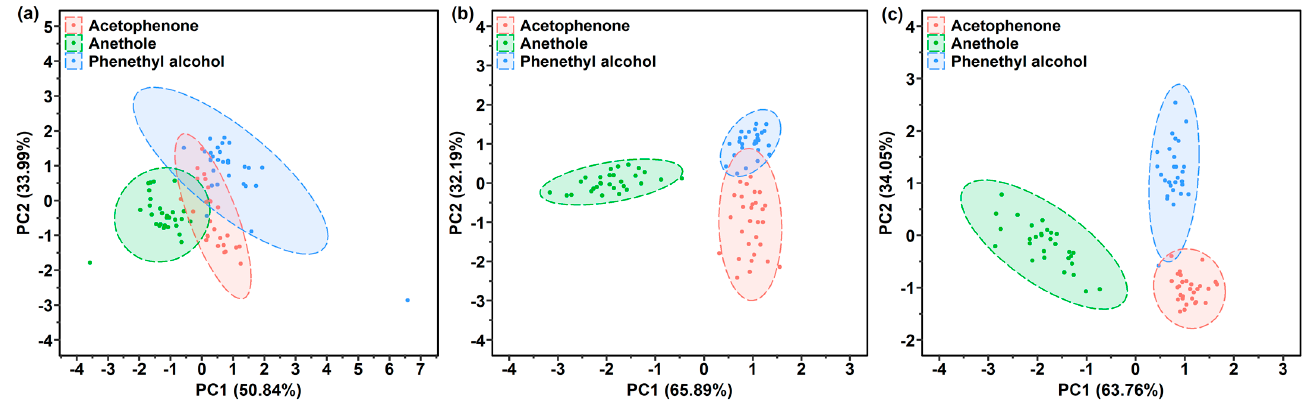
Figure 7. PCA score plots by ( a ) PAA-coated, ( b ) PMMA-coated or ( c ) PDMS-coated SERS gas sensor used for the gas detection of phenethyl alcohol, acetophenone and anethole.